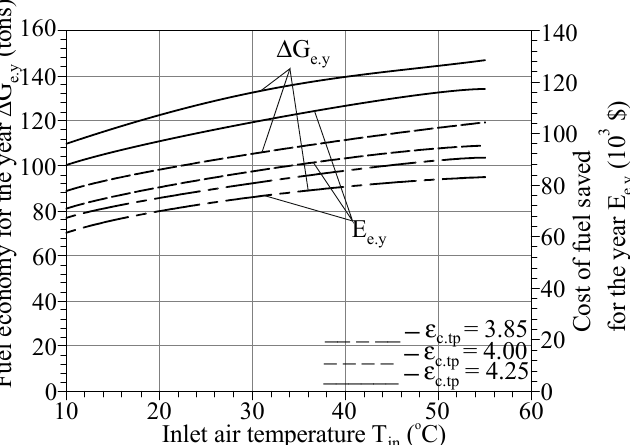
Figure 26. Dependences of the fuel economy for the voyage Δ G e . v ; the cost of fuel saved for the voyage E e . v ; and reduction of the specific fuel consumption by diesel generators, Δ g e , at different total pressure increase, ε c . tp , on the inlet air temperature, T in .